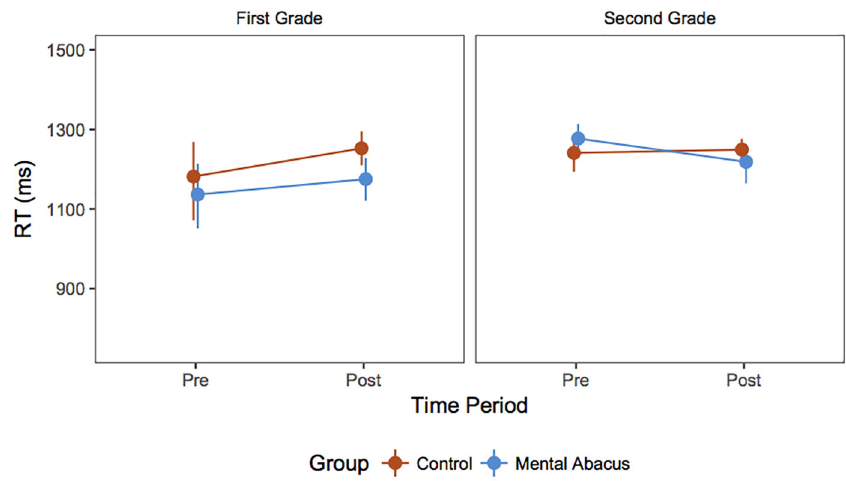
Figure 6. Reaction times for the go/no-go task. Plotting conventions are as above.